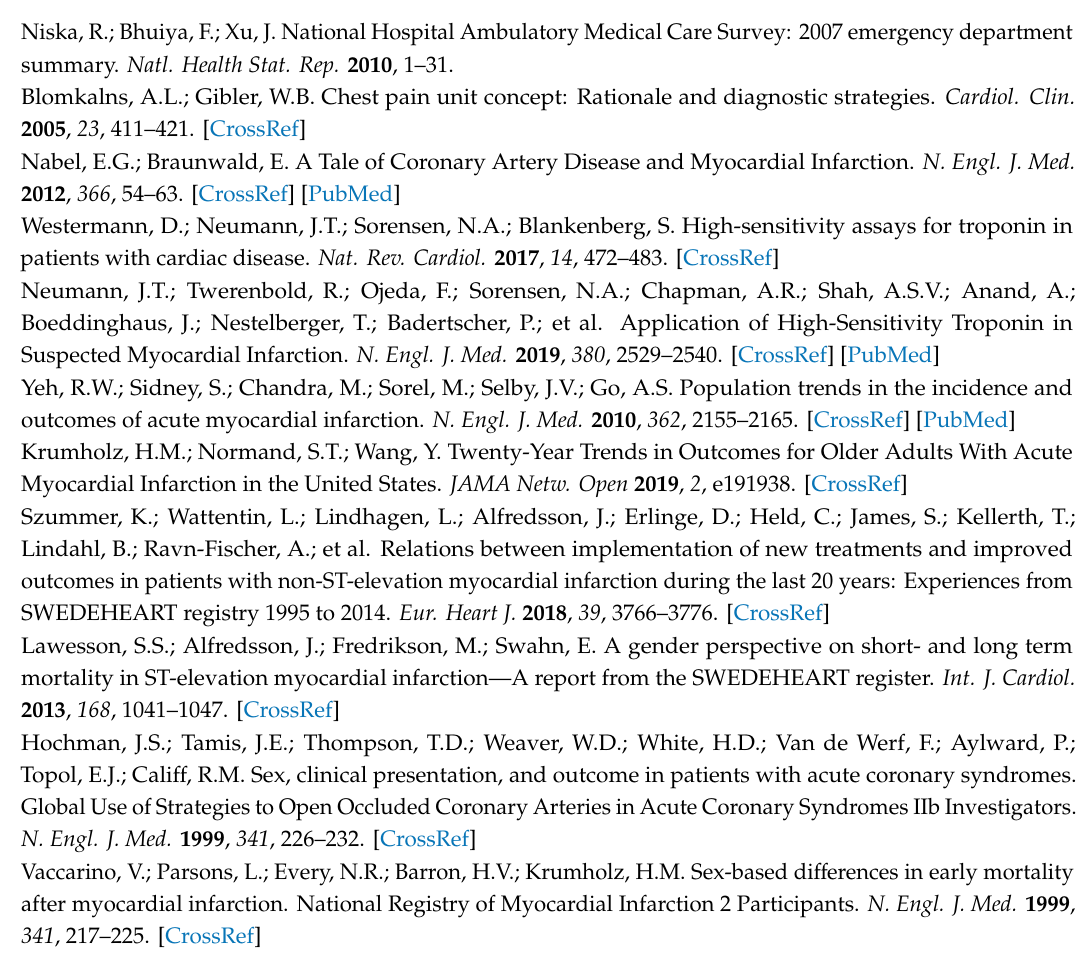
Table S1: International classification of diseases (ICD), and Operationen und Prozedurenschlüssel (operations and procedure classification; OPS) codes used for the analysis. Table S2: Characteristics of females and males according to type of stent placed with a comparison of bare-metal stents (BMS) and drug-eluting stents (DES). Table S3: Characteristics of female patients presenting with ACS per year. Table S4: Characteristics of male patients presenting with ACS per year. Table S5: Males’ and females’ age-adjusted incidence rates of ACS, NSTEMI, STEMI, and UAP, and inhospital mortality per 1000 person years from 2005 to 2015. ACS, NSTEMI, STEMI, and UAP incidences were calculated using Germany’s age distribution on 31 December of each year, while incidences of inhospital mortality were calculated using Germany’s ACS distribution for each year. Table S6. Crude rates of ACS and inhospital mortality per age category for females and